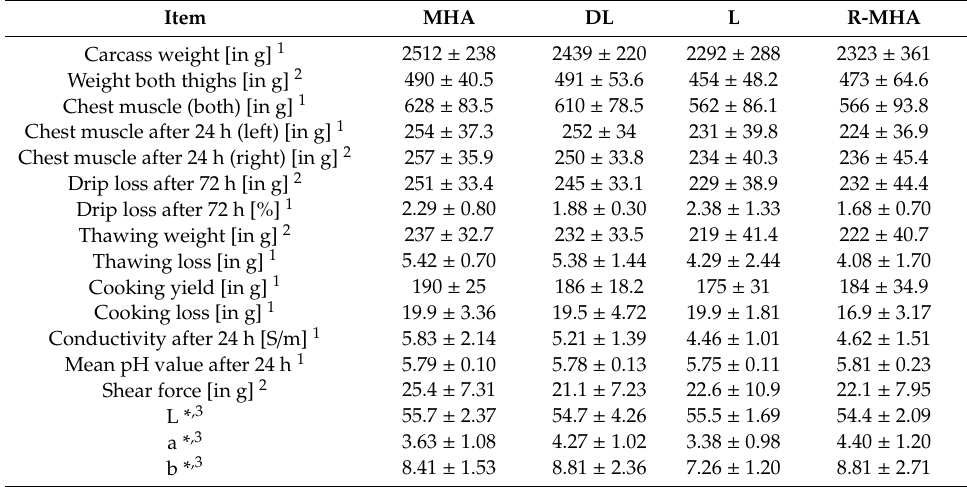
Table 10. Parameters of slaughter yield (n = 24 broilers), analyzed by the Institute for Food Quality and Food Safety (day 35).